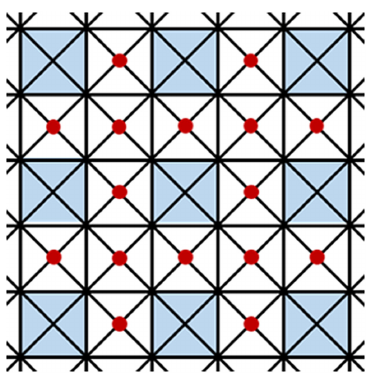
FIG. 2. Extensiveness of magic. After measuring the red ver- tices by Pauli observables, the system is left with decoupled CCZ blocks (colored in